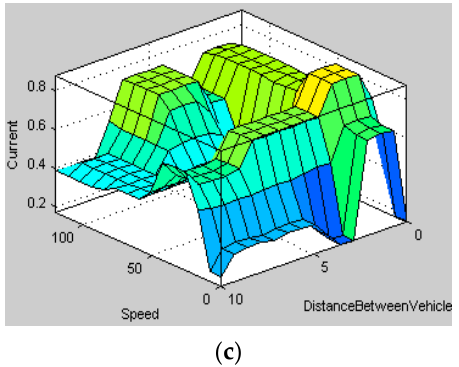
Figure 9. Rules for all the input parameters; ( a ) pedal position, ( b ) distance between the vehicles, ( c ) speed of the vehicles.